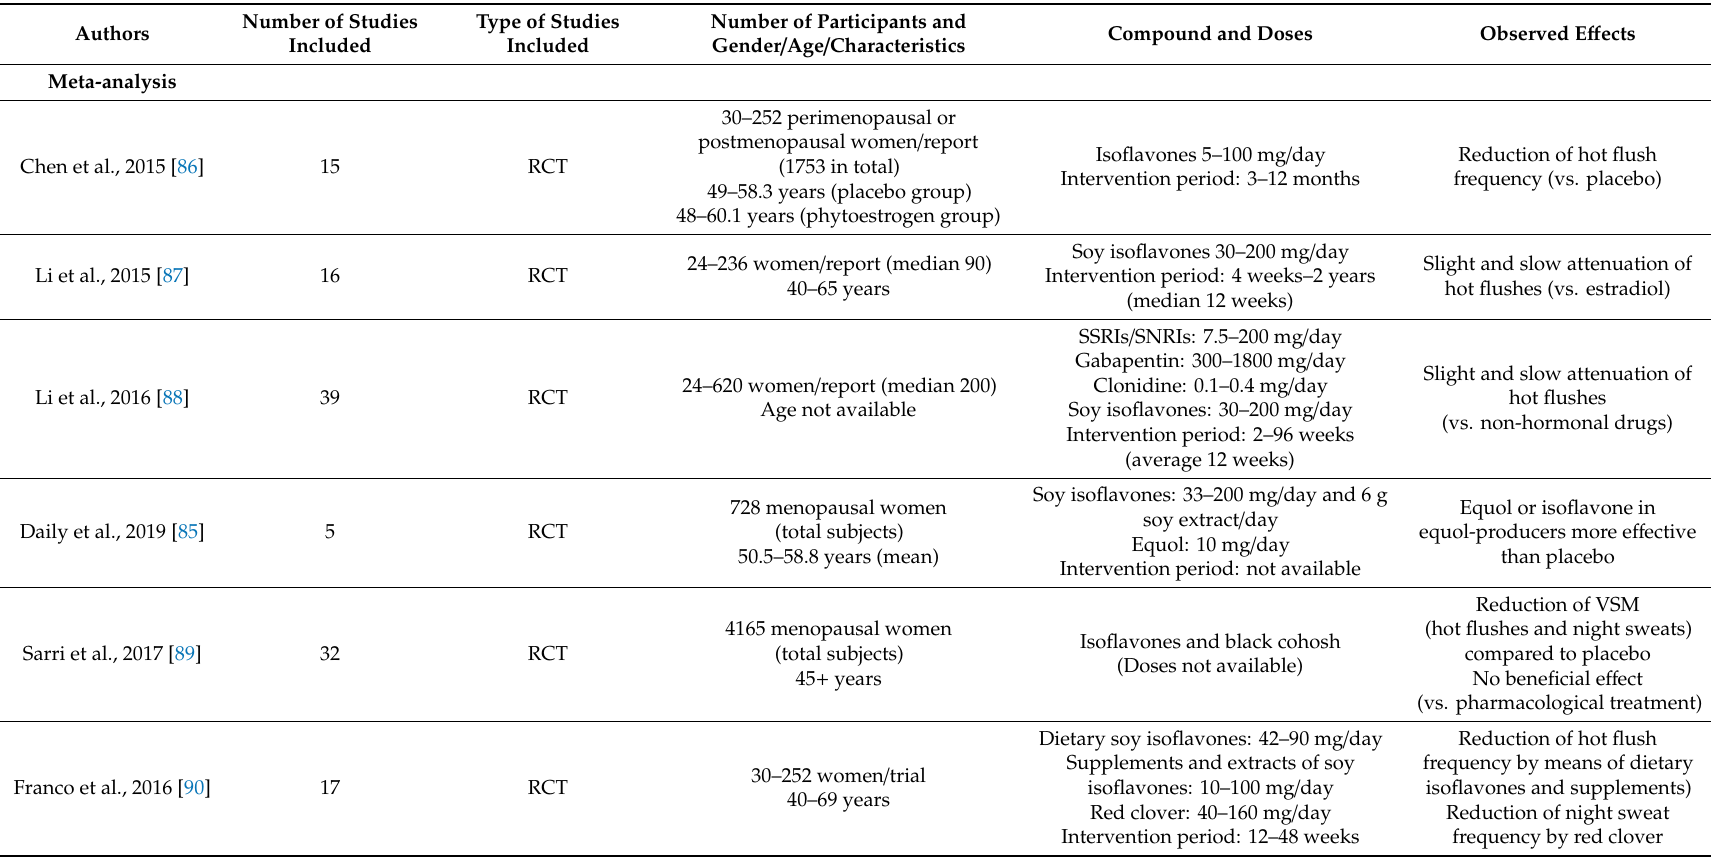
Table 5. E ff ects of isoflavones in menopausal